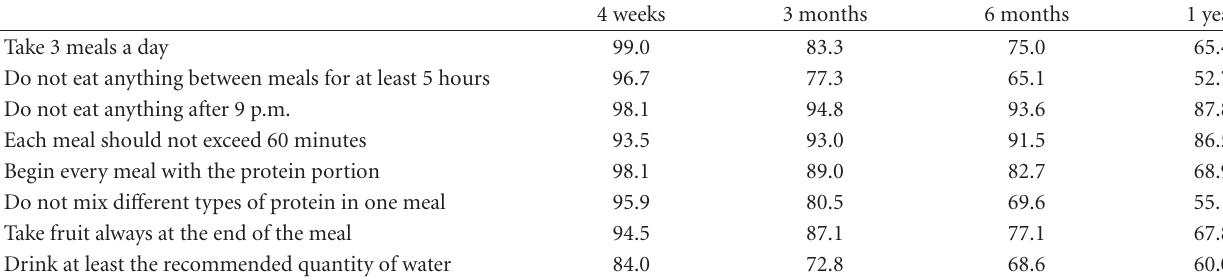
Table 1: Adherence to the eight basic rules of the program.